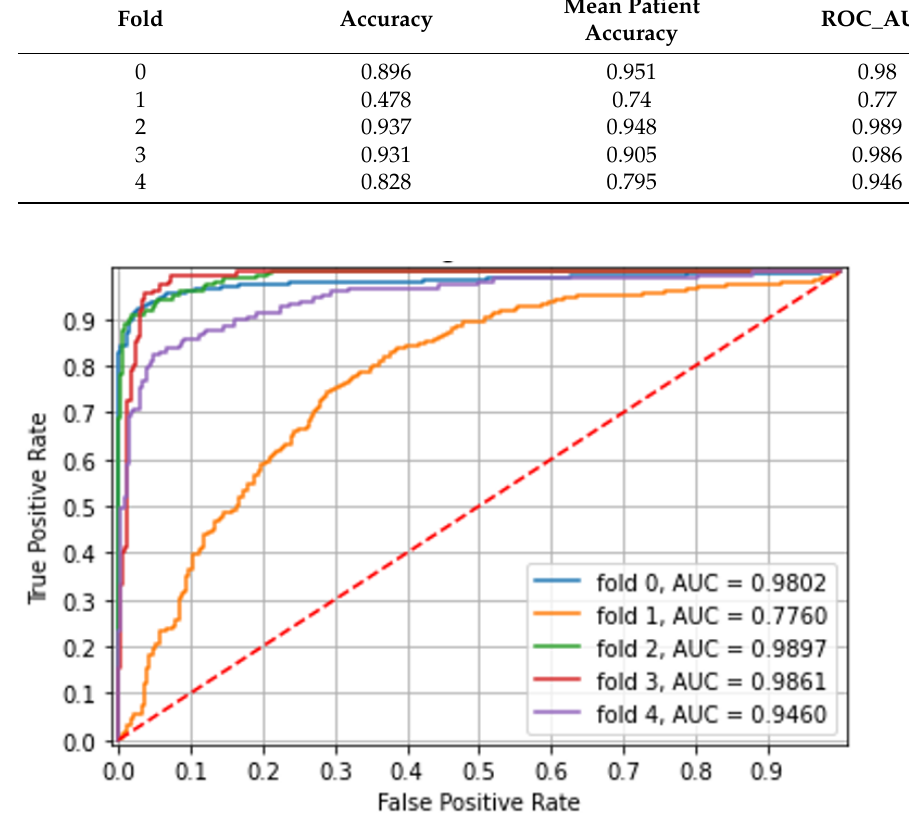
Figure 4. Experiment 4—Identification of colonic ulcerated mucosa.